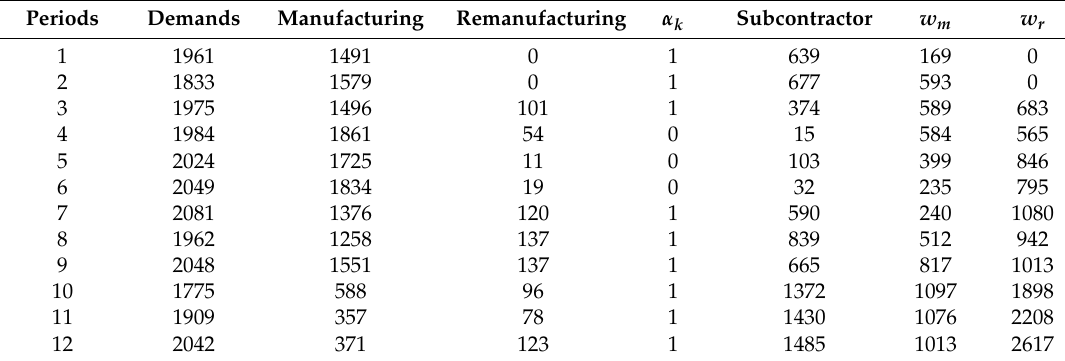
Table 1. Production plan during H = 12